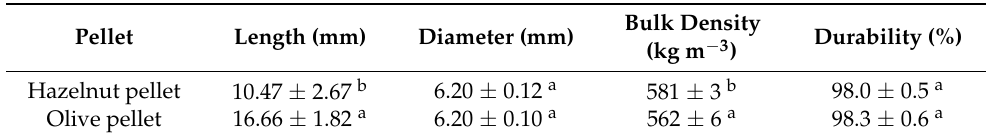
Figure 3. Olive wood ( A ) and hazelnut pellet ( B ) obtained using the 4 kW Bianco Line pelletizer. Table 3. Length, diameter, bulk density, and durability detected for hazelnut and olive pellets. t -test, different letters indicate statistically significant differences ( p < 0.05).